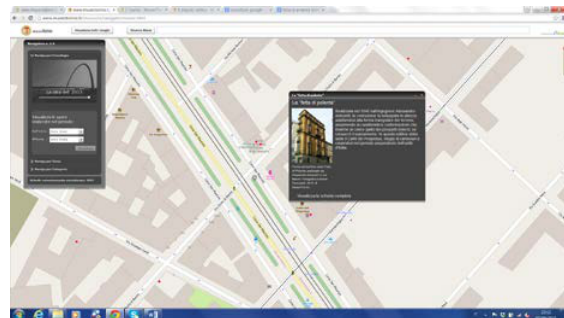
Figure 10. The “Fetta di Polenta” designed and realized by Alessandro Antonelli.